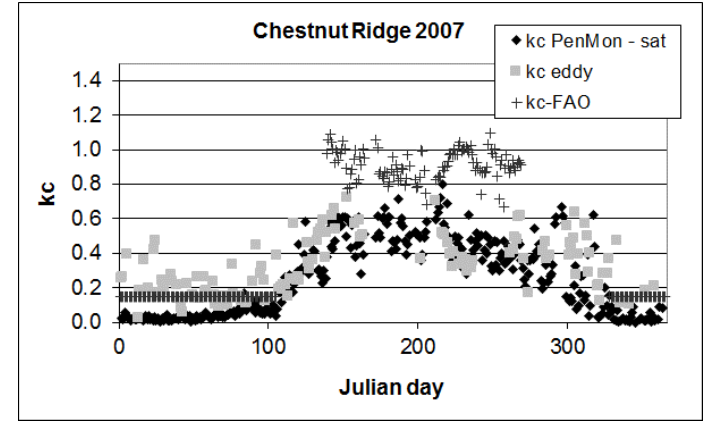
Figure 4. Crop coefficient values for Chestnut Ridge eddy covariance station for 2007.